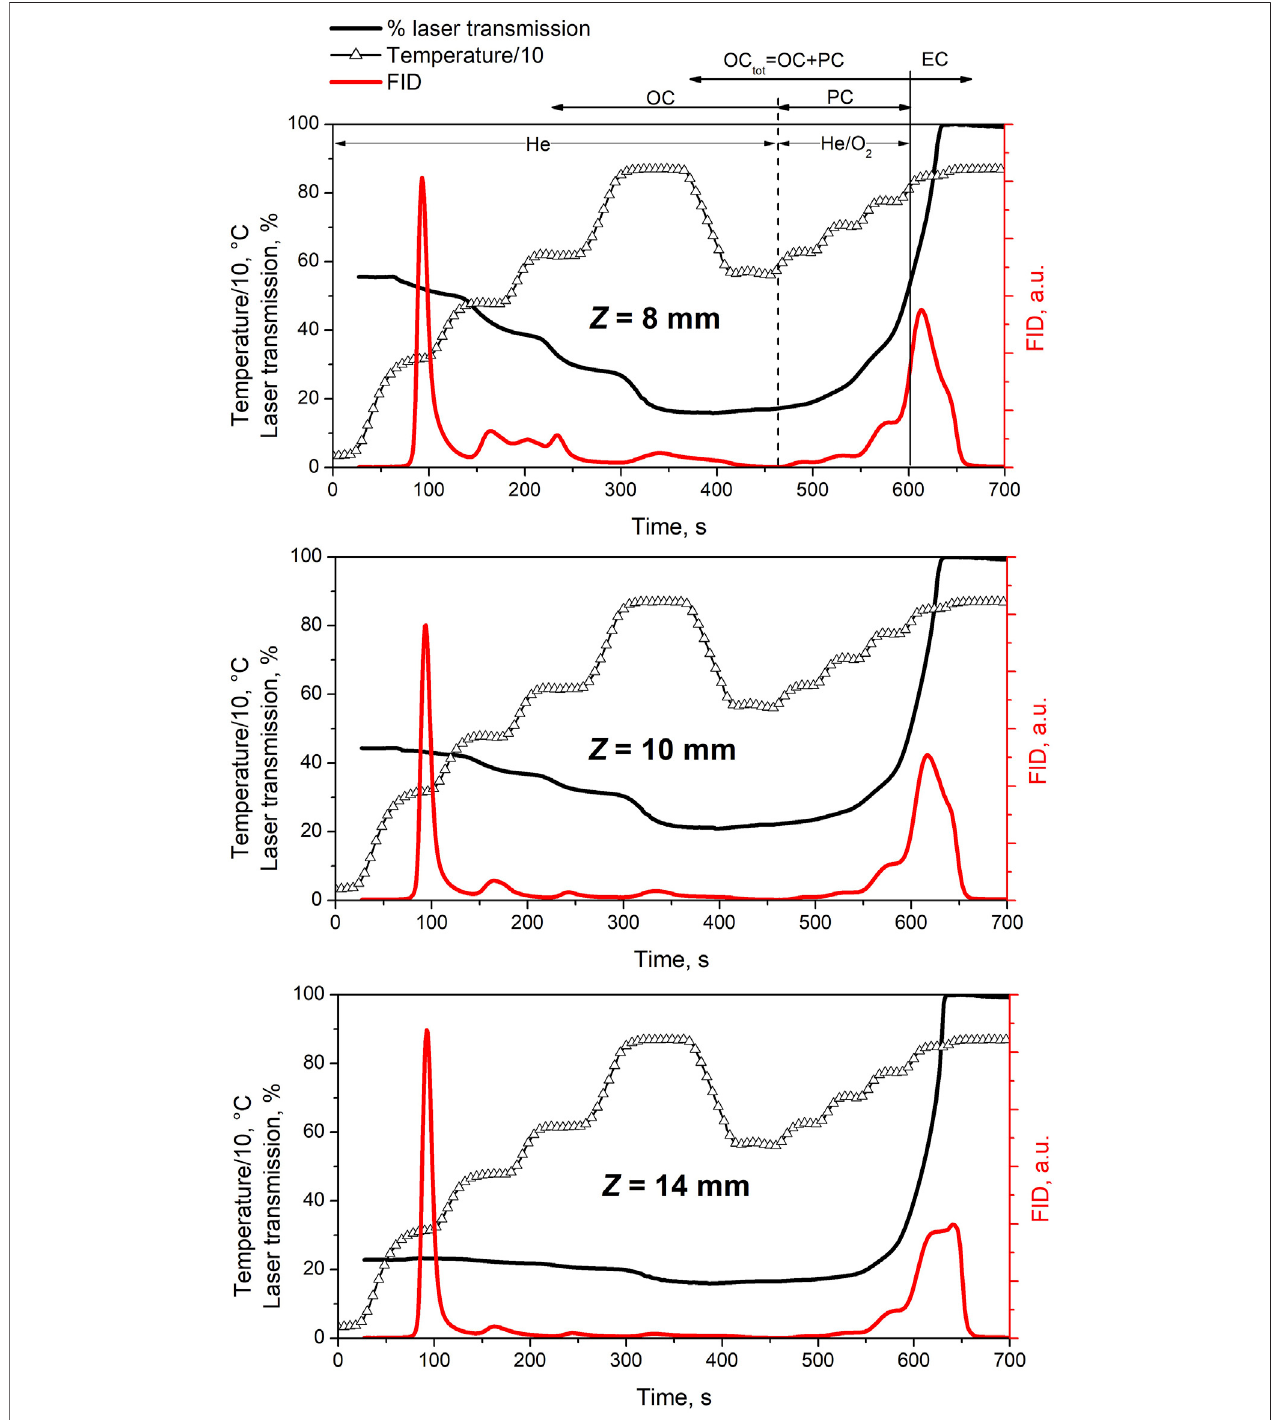
FIGURE 3 | Thermograms showing the adopted temperature program (line with triangles), the measured laser transmission (black line) and FID signal (red line) representative of carbonaceous material evolving off the quartz fi lter as a function of time. The vertical lines show the OC tot /EC split (solid line), and the division between OC and “ pyrolytically converted ” OC, labeled PC (dashed line). Data refers to three soot samples at Z = 8 mm, Z = 10 mm and Z = 14 mm.